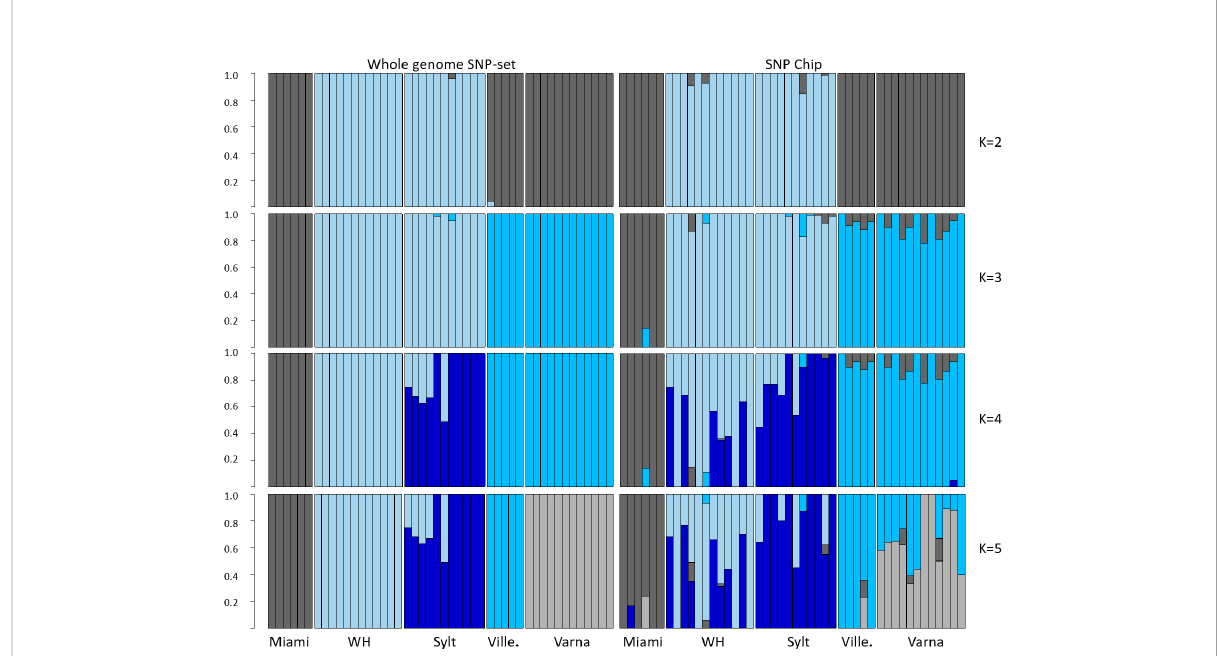
FIGURE 2 Structure plots comparing results of Mnemiopsis leidyi SNP sets from re-analysed whole genome re-sequencing at 832,323 SNPs (left) and newly developed SNP Chip at 116 SNPs (right) of the ctenophore for all native (Miami and Woods Hole – WH, USA) and invasive (Sylt, GER; Villefranche-sur-Mer – Ville., FR; Varna, BG) populations for the most likely scenario at K = 2 and alternative scenarios at K = 3 –